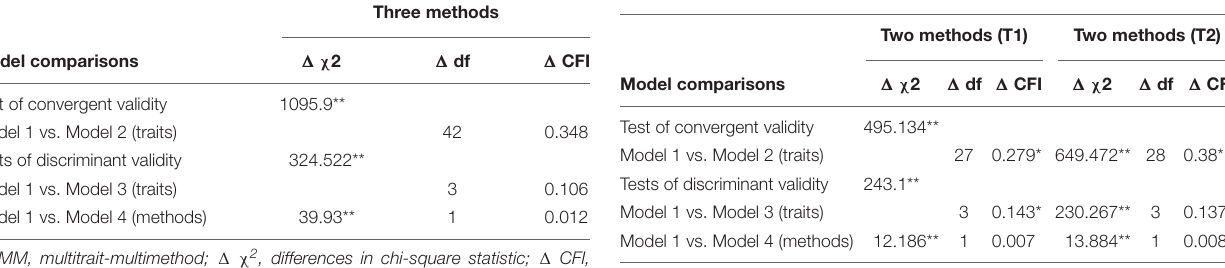
TABLE 5 | Comparison of goodness-of-fit indices. TABLE 7 | Goodness-of-fit indices comparisons with two methods only (student and only one teacher).